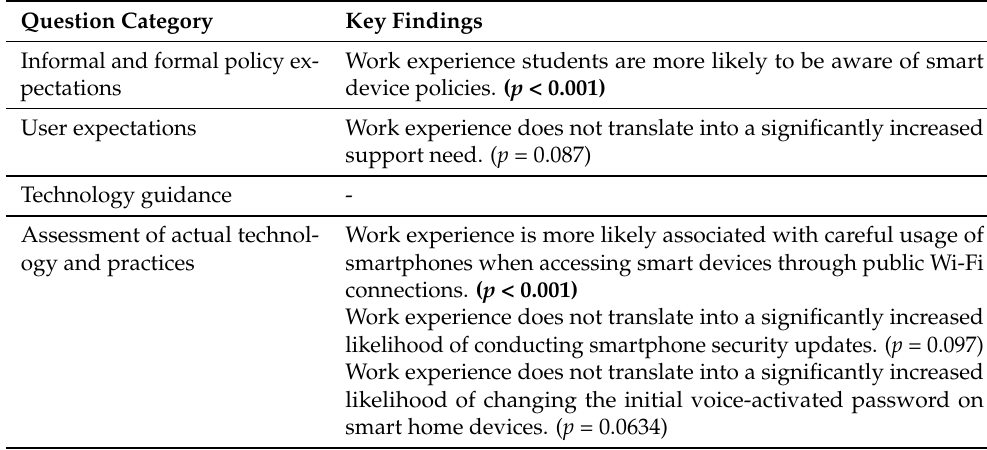
Table 6. Summary of key findings: Smart home